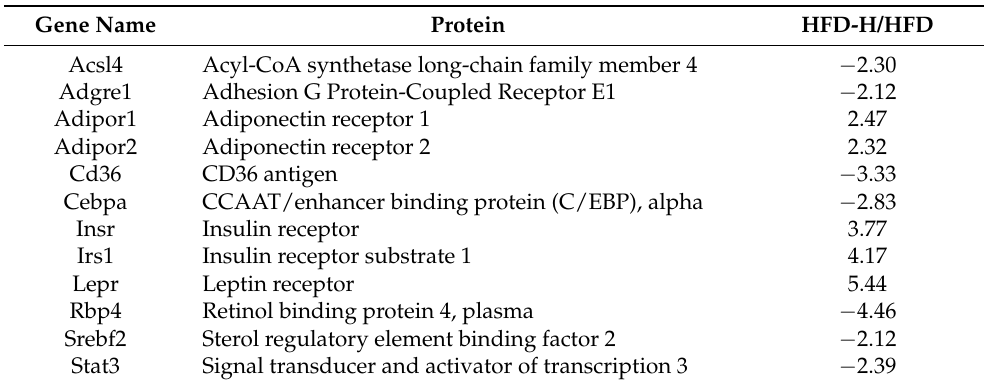
Table 2. Expression profiles of genes in HFD-H/HFD which were significantly upregulated or downregulated by 2-folds.